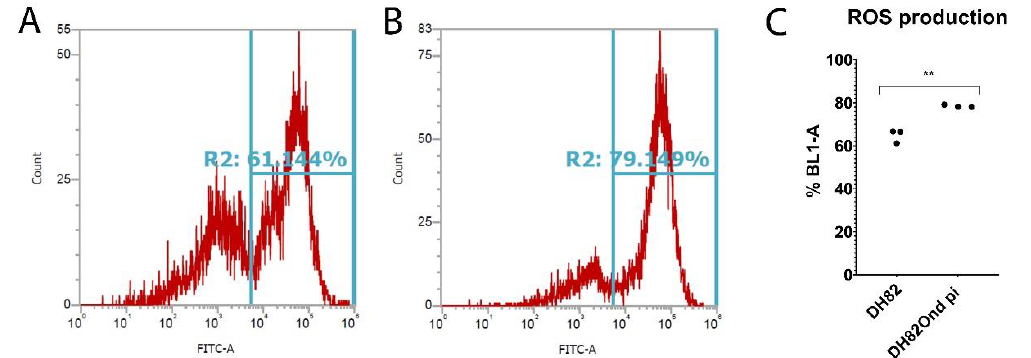
Figure 2. Determination of oxidative burst by fluorescence activated cells sorting (FACS) in non-infected ( A ) and persistently canine distemper virus (CDV) infected ( B ) DH82 cells. The percentage of cells positive for ROS-formation was measured by flow cytometry (BL-1) using a DCF fluorescence probe. ( C ) BL-1 positive cells revealed a significantly increased ROS production among persistently CDV-infected DH82 cells compared to non-infected controls. All data are shown as dot plots with means ± standard error of mean. Significant differences ( p ≤ 0.05, unpaired t -test) are labeled by asterisks (** p ≤ 0.01).